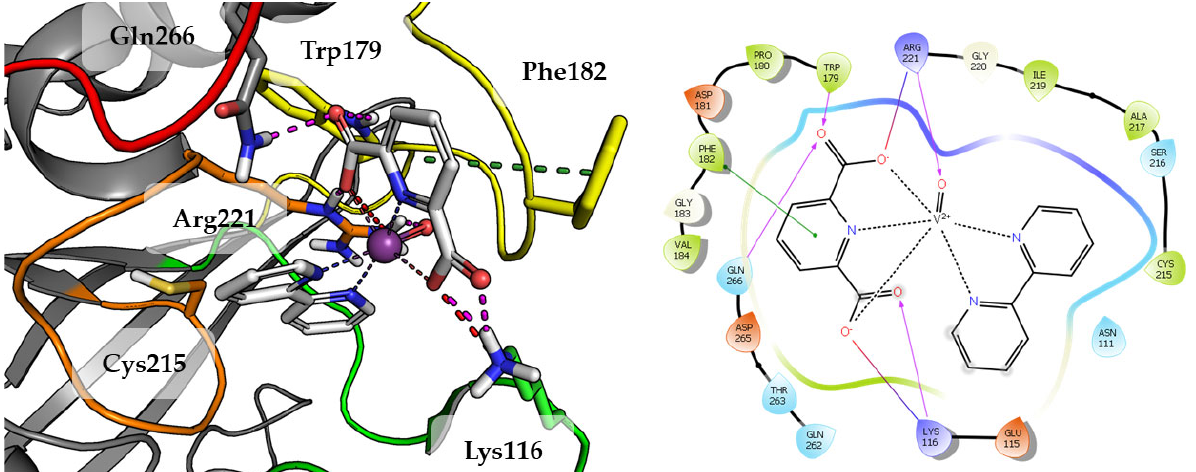
Figure 5. Docking result of Compound 2 to the PTP1B active site (PDB: 1ONZ). Left panel presents a studied compound as white sticks with protein represented by a gray cartoon. Significant loops are highlighted with separate colors; P ‐ loop in orange, WPD ‐ loop in yellow, E ‐ loop in green, and Q ‐ loop in red. The most important amino acids are represented as sticks with the same color code. Coordinate bonds are marked with thin dotted lines. Hydrogen bonds are marked in magenta, ionic interaction in red, aromatic π‐π or CH ‐π in green. Right panel presents 2D ligand interaction diagram. Compound 3 was one of the lower rated by scoring function (GoldScore value 48.04), what correlates with the results of biological studies. The final pose of Compound 3 is shown in Figure 6.